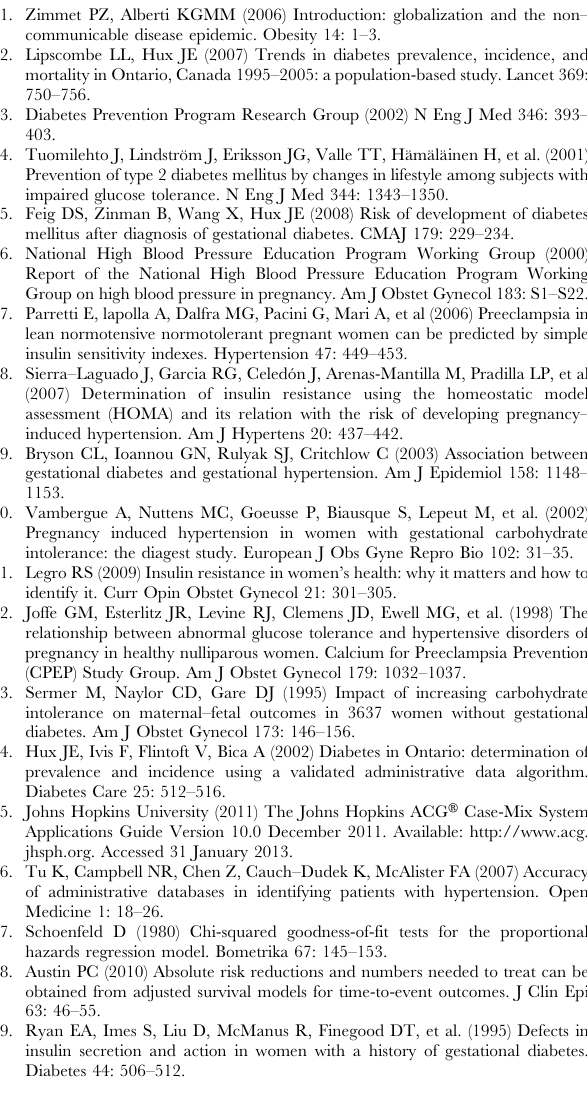
Table S1 Distribution of co-morbidity categories (collapsed ambulatory diagnostic groups)* among women stratified by gestational diabetes diagnosis. *Collapsed ambulatory diagnostic groups [CADGs] were created using the Johns Hopkins Adjusted Clinical Groups (ACG) System. CADG category number 12 (pregnancy) was not included in the analyses.